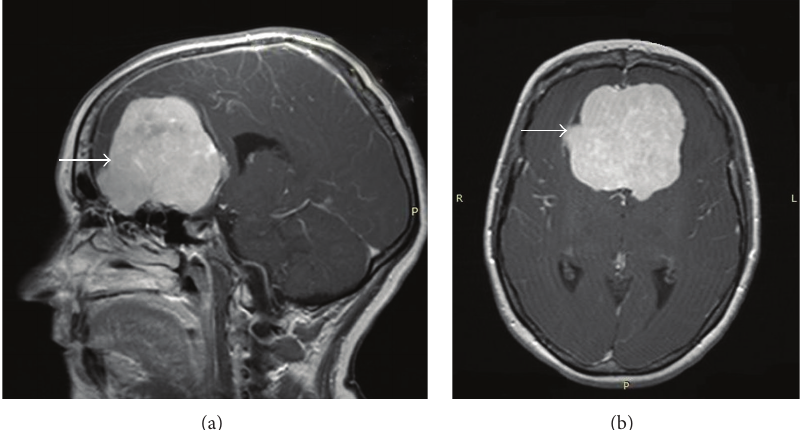
Figure 1: Arrows show a large lobulated extra-axial tumor compressing the olfactory sulcus in gadolinium-enhanced T1-weighted MRI.